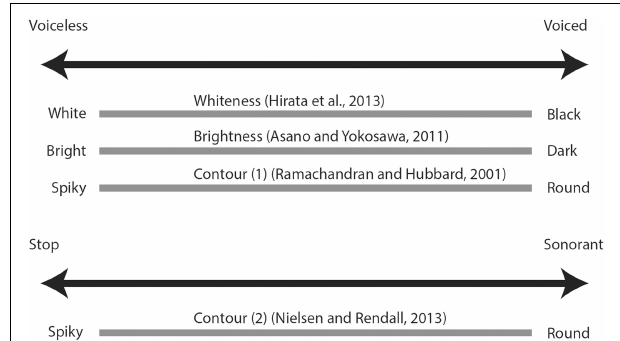
FIGURE 2 | Diagram of attested cross-modal mappings to linguistic sound for consonant properties.